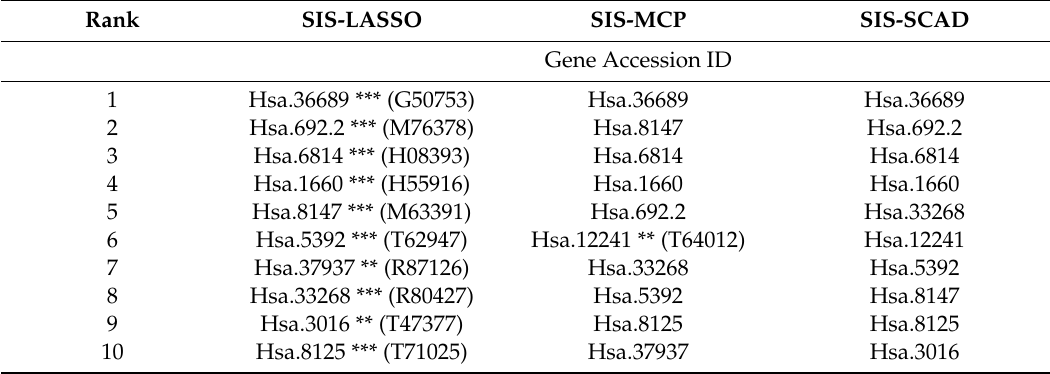
Table 4. Top 10 ranked genes with highest selection frequency from the lists of ranking genes using 100 times resampling approach across three methods of SIS-LASSO, SIS-MCP, and SIS-SCAD on both the colon cancer and the lung cancer gene expression